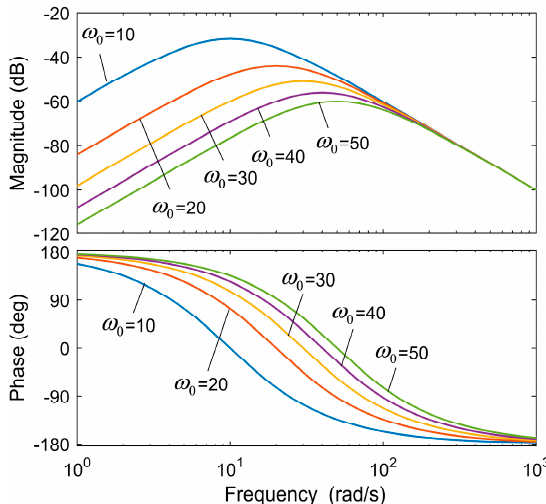
Figure 8. Frequency-domain characteristic curve of observed noise.